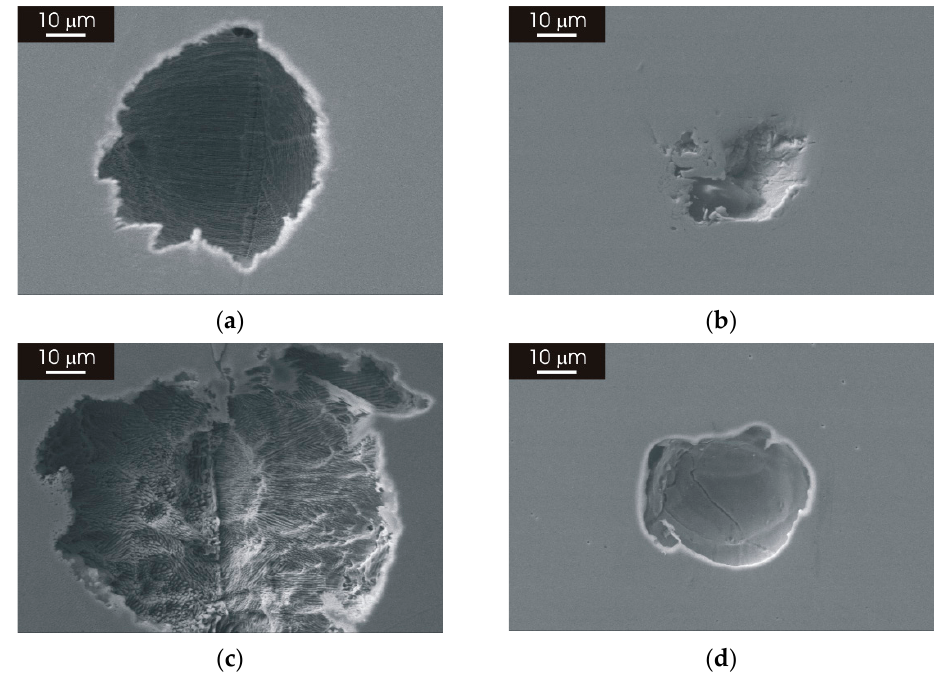
Figure 9. SEM micrographs of heat-treated L-PBF-XY 316L stainless steel after galvanostatic polarization at 1 mA/cm − 2 for 1 h in 3.5 NaCl solution. ( a ) Heat treated at 400 °C for 2 h, galvanostatic polarization in neutral solution; ( b ) heat treated at 1100 °C for 2 h, galvanostatic polarization in neutral solution; ( c ) heat treated at 400 °C for 2 h, galvanostatic polarization in solution with pH 1.8; ( d ) heat treated at 1100 °C for 2 h, galvanostatic polarization in solution with pH 1.8.